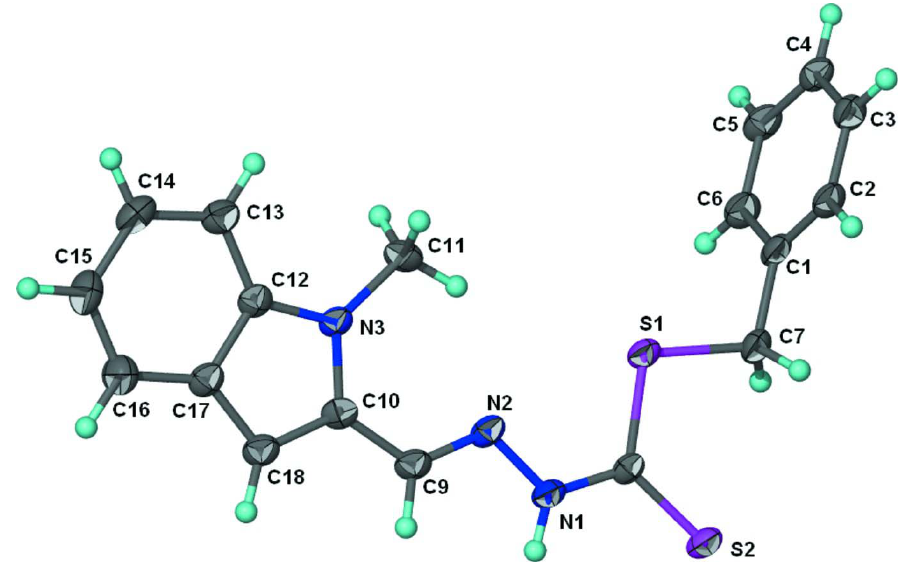
Figure 1 The molecular structue of (I) at the 70% probability level. Hydrogen atoms are drawn as spheres of arbitrary